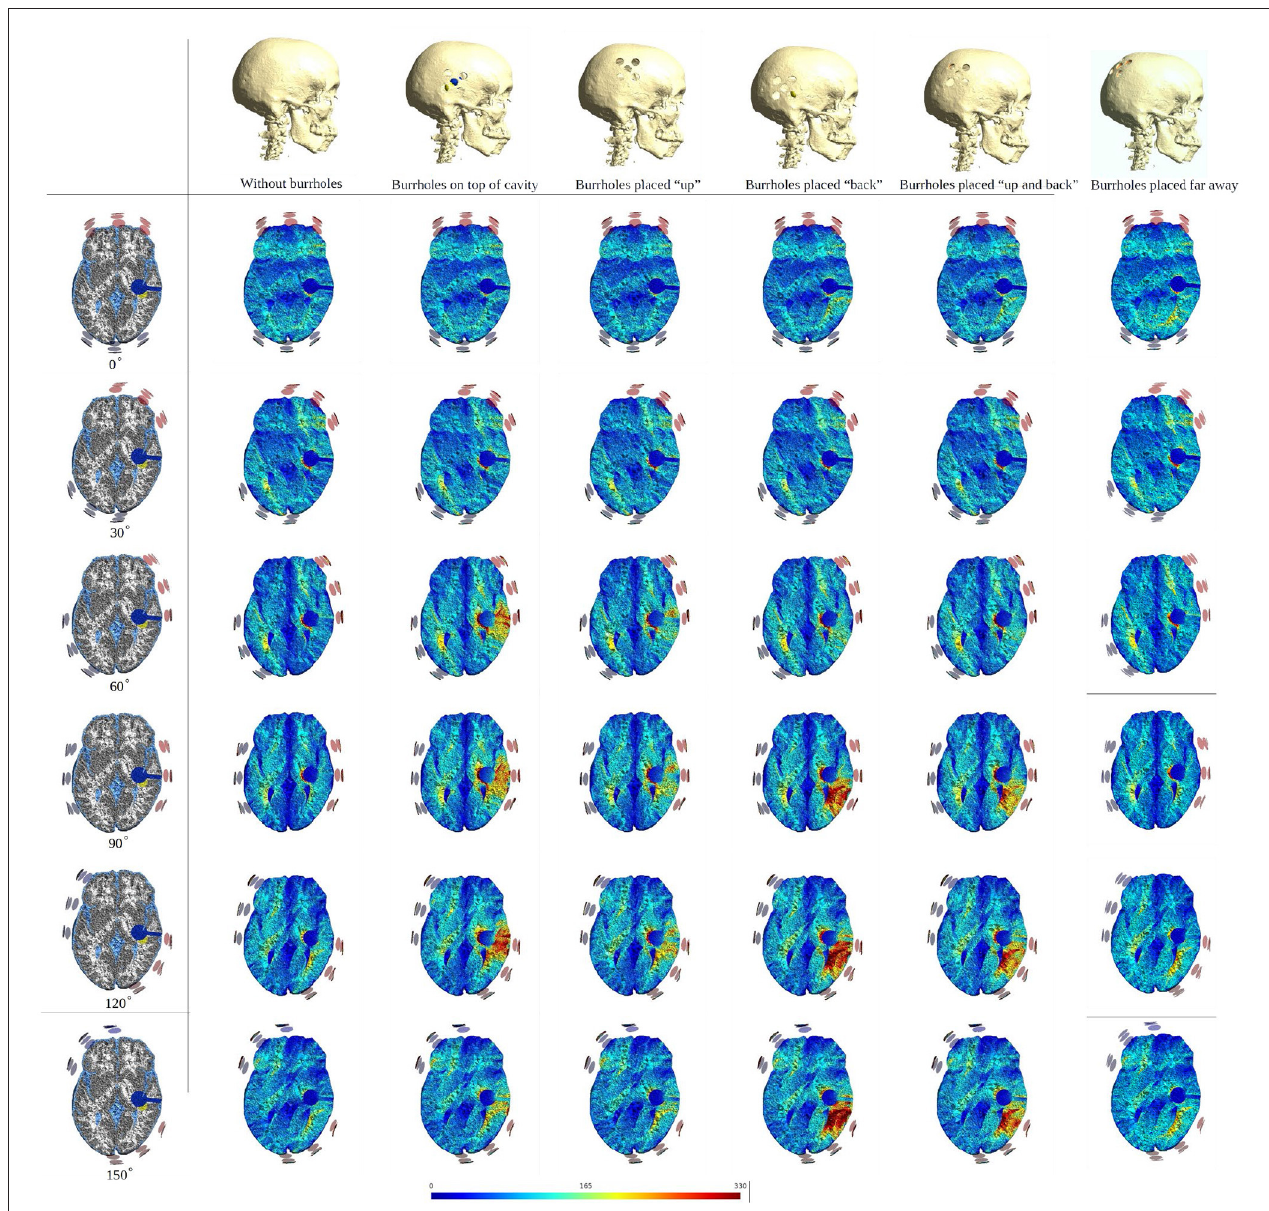
FIGURE 6 | Axial view of TTFields intensity under array layouts 0 ◦ , 30 ◦ , 60 ◦ , 90 ◦ , 120 ◦ , and 150 ◦ . Different configurations of SR surgery and the control without burr holes are studied as illustrated in the top row. The first column presents an equivalent anatomical representation of the head model. The following two columns show a significant increase in field intensity when the burr holes are placed directly over the resection cavity and residual tumor, and the electrodes are placed close to or directly above the burr holes. Significant enhancement is also achieved with posterior displacement of the burr holes and slight rotation of arrays. Minor, limited field enhancement is observed when burr holes are placed far from the resection cavity and residual tumor. This experiment demonstrates how various burr hole placements impact the electric field in the resection cavity and residual tumor. Therefore, a recommended SR surgery configuration is to place burr holes directly above the resection cavity and residual tumor to maximize the electric field